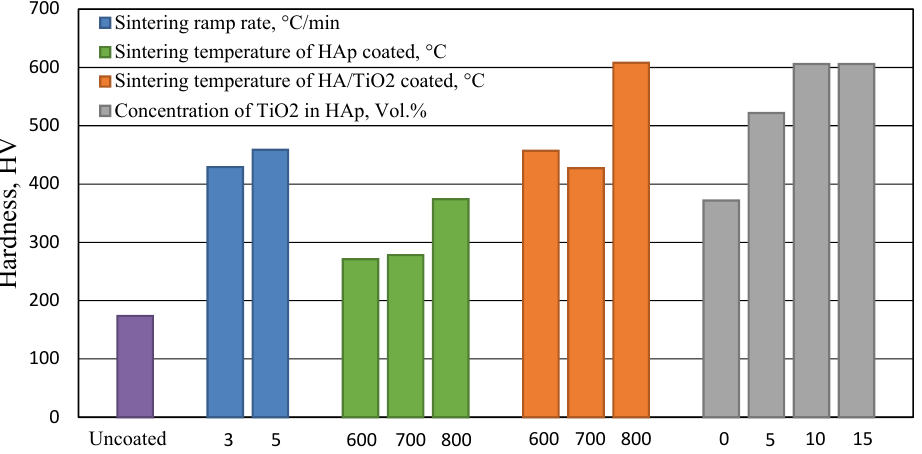
Figure 6. E ff ect of TiO 2 addition and sintering parameters on the coating hardness (Data from